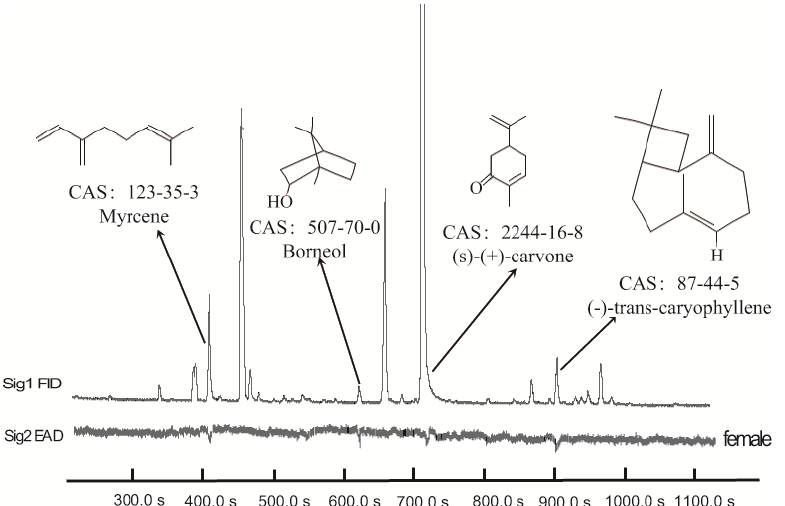
Figure 1. Coupled gas chromatography-electroantennogram detection of M. spicata volatiles. The upper trace is the GC chromatogram; the lower inverted trace is the antennal response of a female A. bungii ; CAS number, chemical names, and structural formulae of antennal-active compounds are indicated.